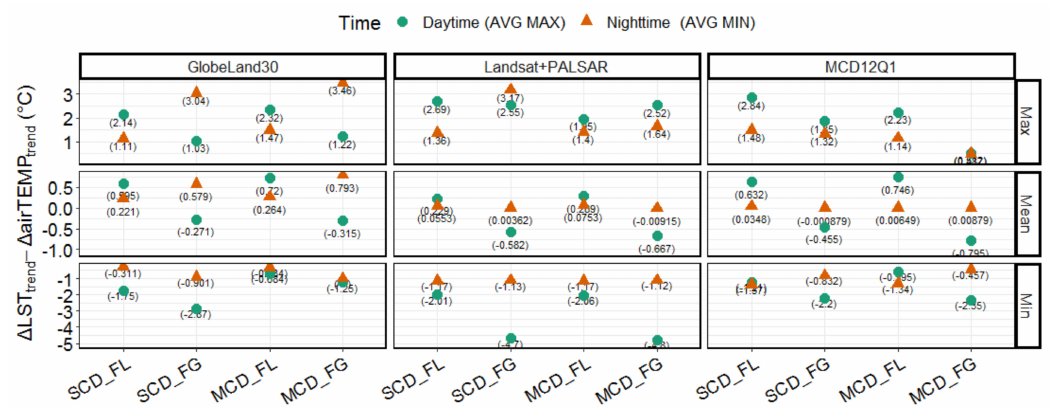
Figure 11. Di ff erences between annual ∆ LST trend and ∆ airTEMP trend (daytime AVG MAX, nighttime AVG MIN) caused by the three dataset-based forest losses (SCD_FL, MCD_FL) and gains (SCD_FG, MCD_FG) estimated by MCD and adjusted SCD in Guangdong Province, China from